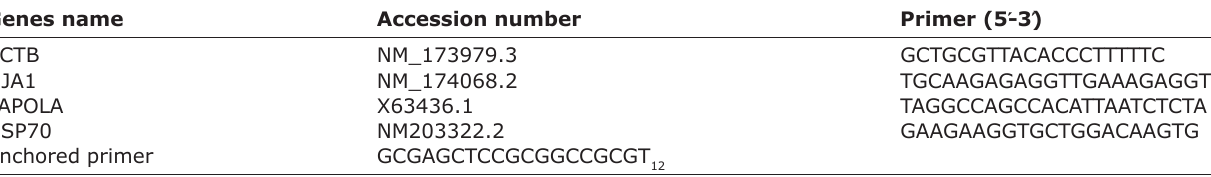
Table-1: Gene specific forward primers and anchored primer used in LM-PAT. Genes name